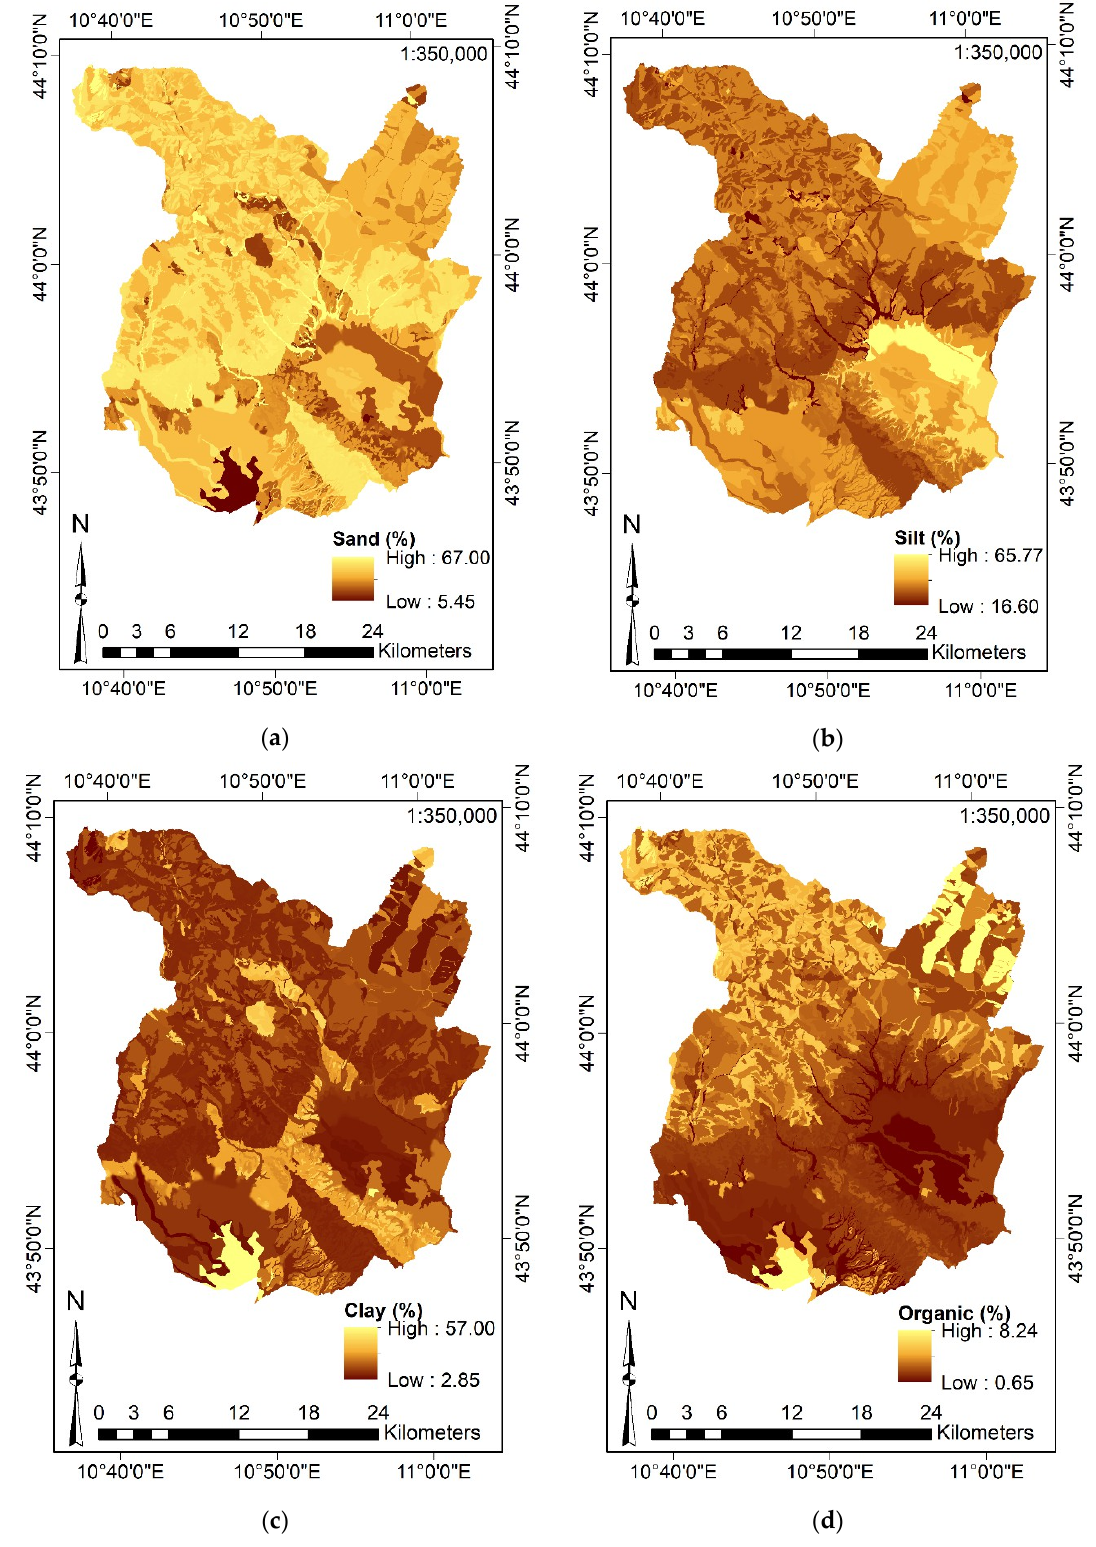
Figure A4. Information collected—subsoil composition: ( a ) Sand content (%); ( b ) Silt content (%); ( c ) Clay content (%); ( d ) Organic content (%).